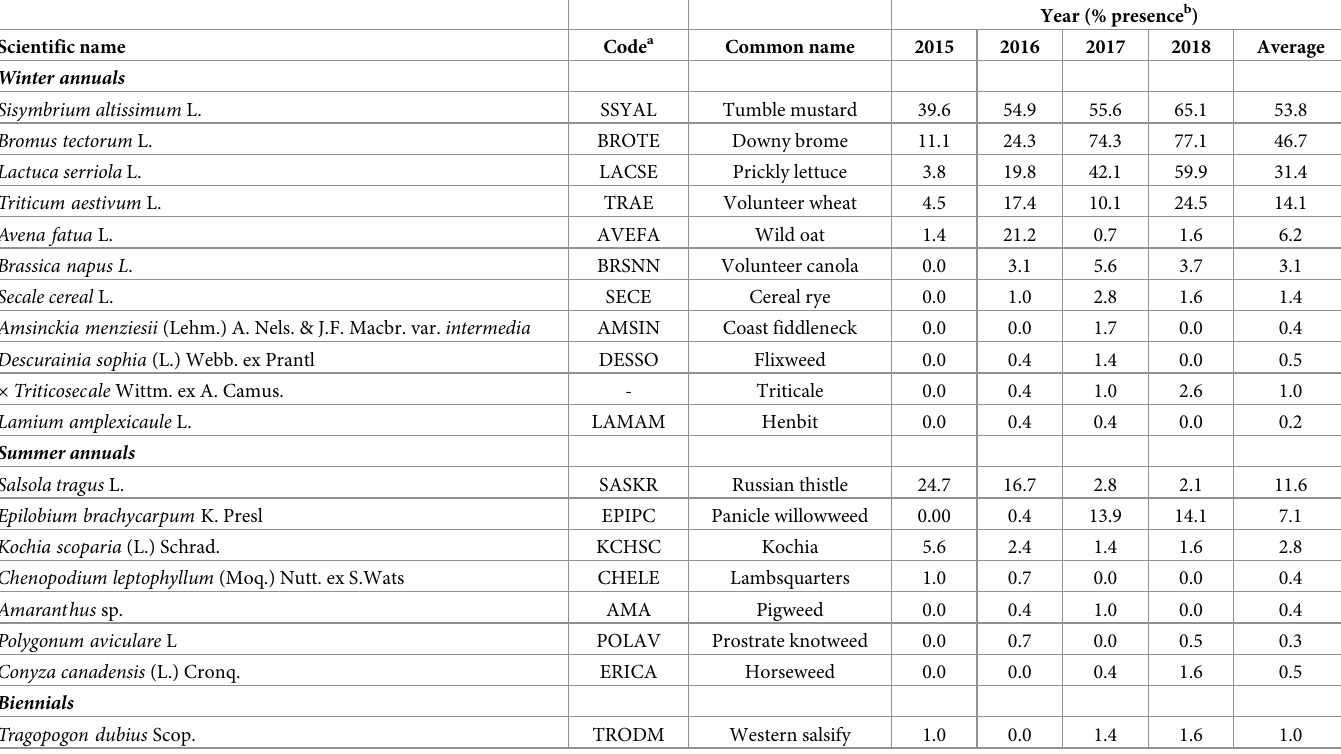
Table 3. Percentage of presence of all species in the weedy (W) and general (G) area, for all samplings in the different